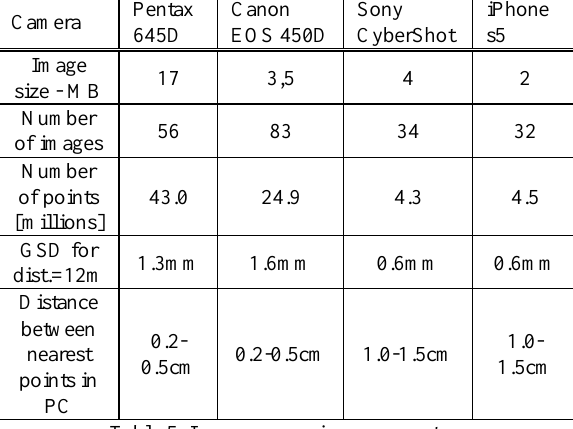
Table 5. Image processing - parameters